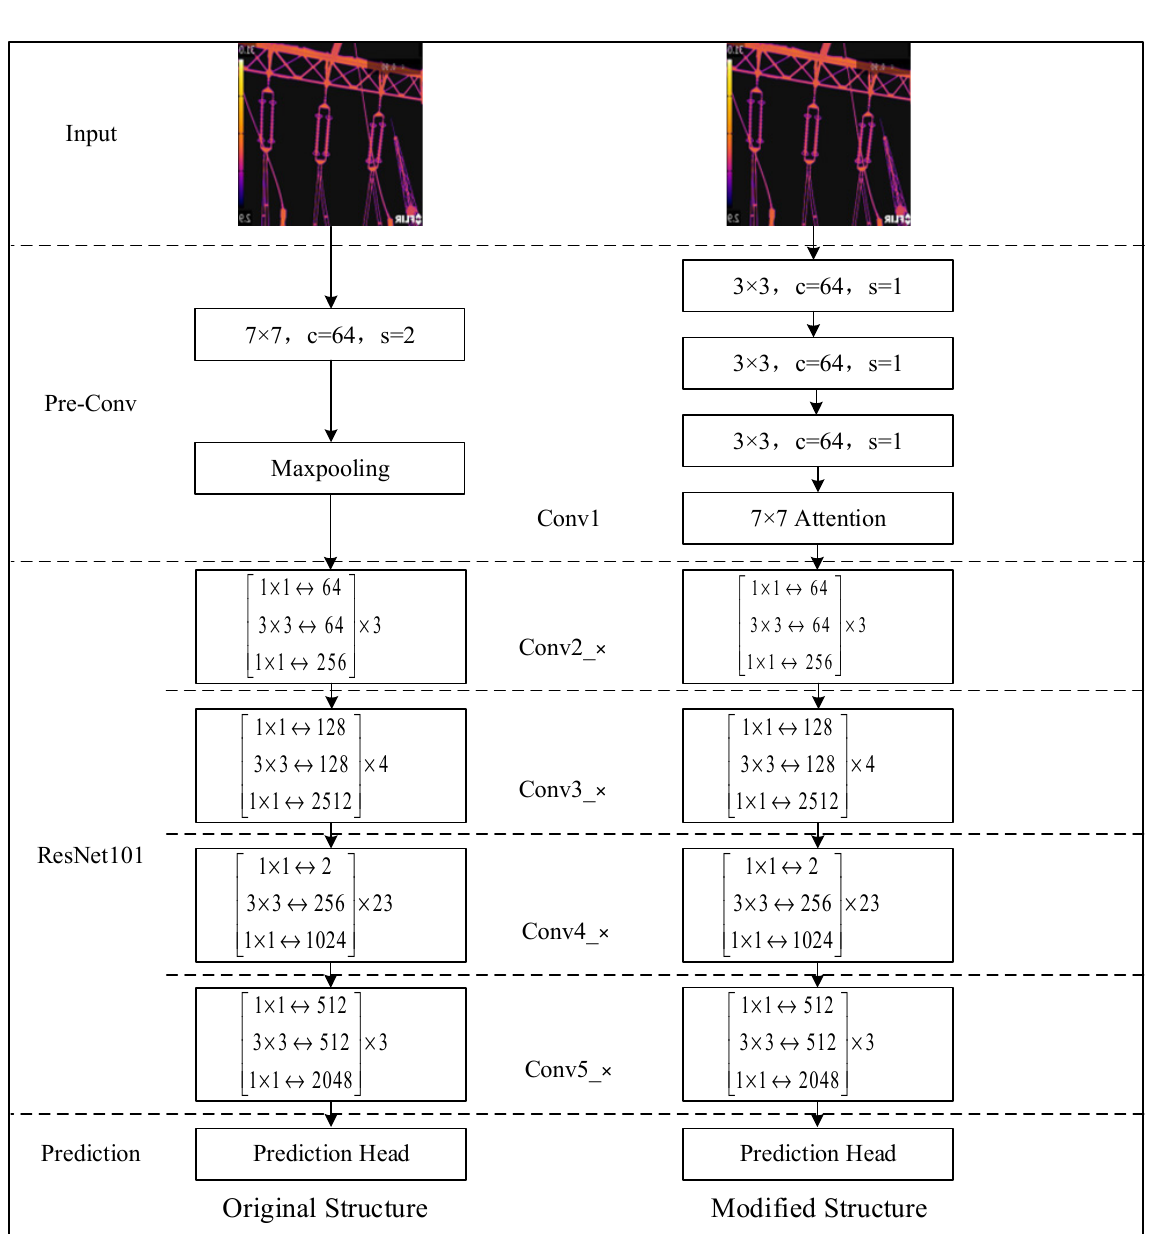
Figure 4. ARG-Mask RCNN backbone network structure.